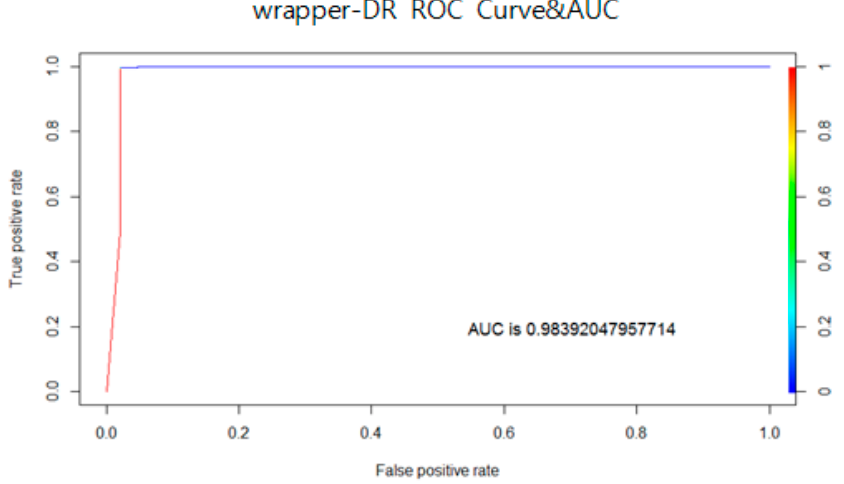
Figure 14. Result of ROC curve in binary decoding: proposal method.